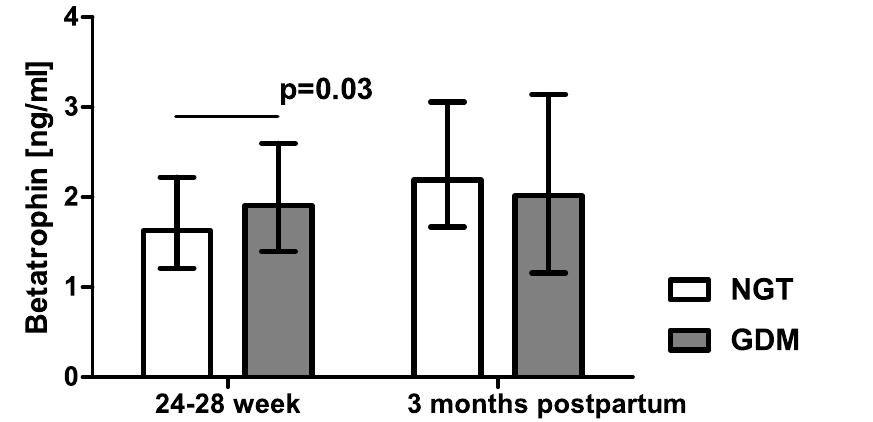
Fig 1. Serum betatrophin concentration in patients with normal glucose tolerance (NGT) and gestational diabetes (GDM) from Group 1; data were analyzed by Mann-Whitney U test and shown as medians with interquartile ranges.